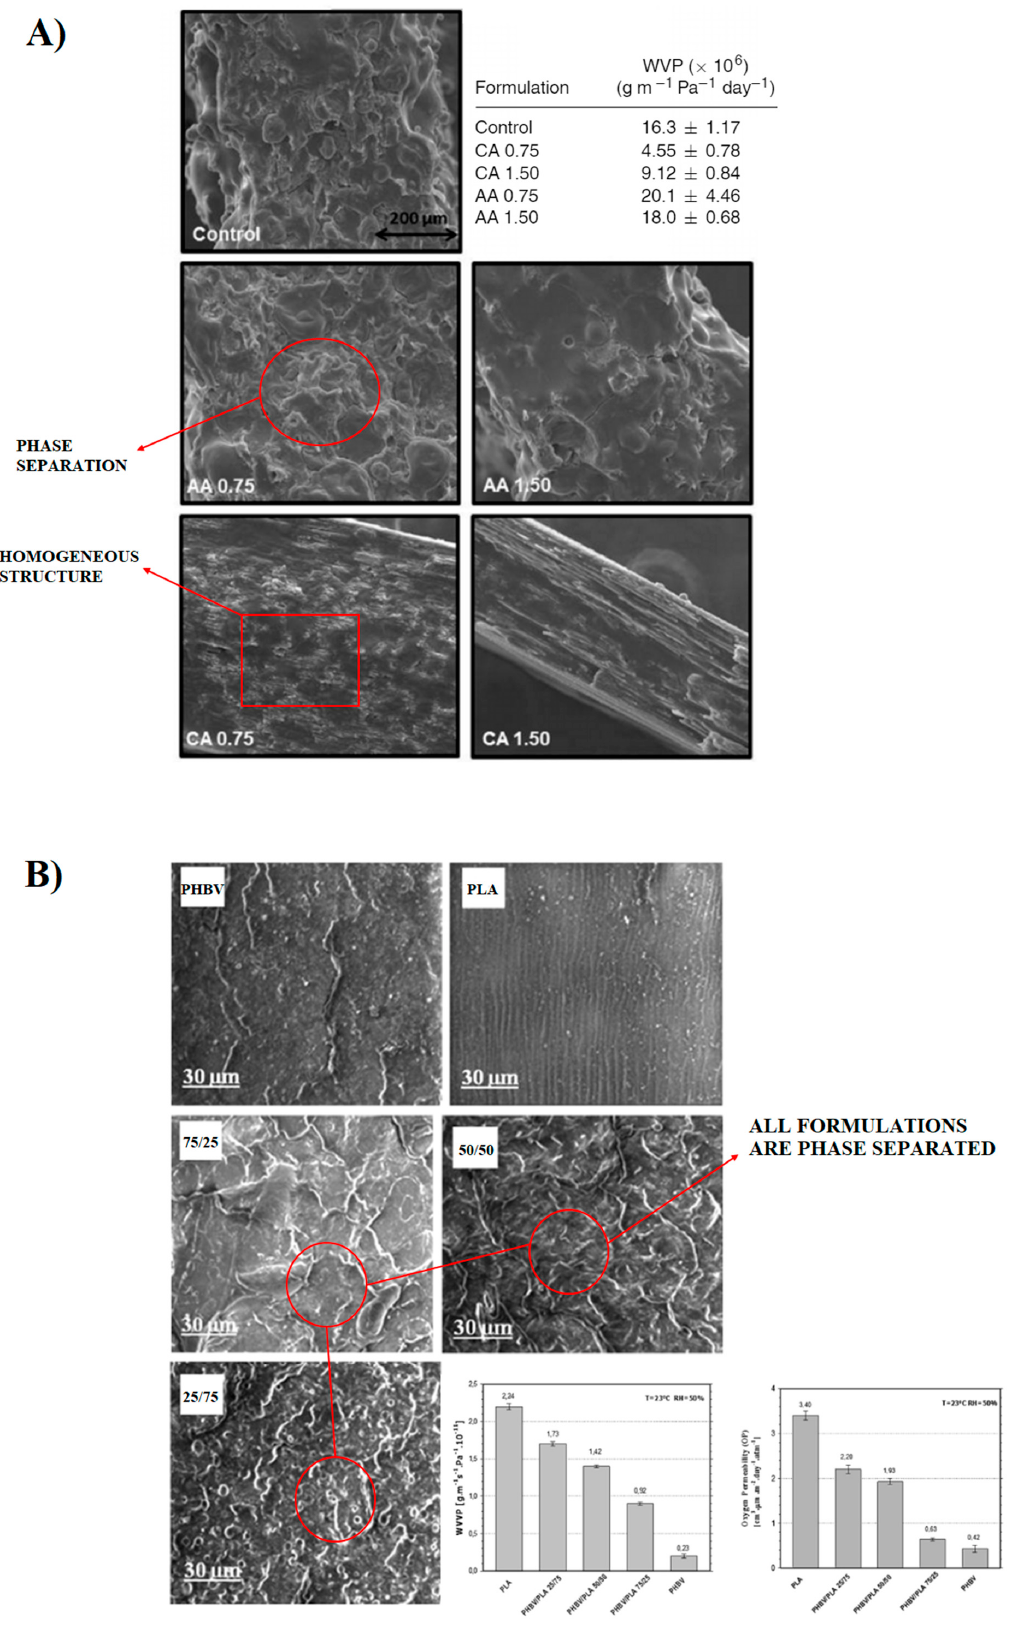
Figure 10. SEM images of ( A ) PLA/TPS sheets with CA (including WVP values), adapted from [191] and ( B ) fracture surface of neat PHBV, neat PLA, and their blends (including WVP and oxygen permeability values), adapted from [193] with permission from Elsevier. Copyright ©